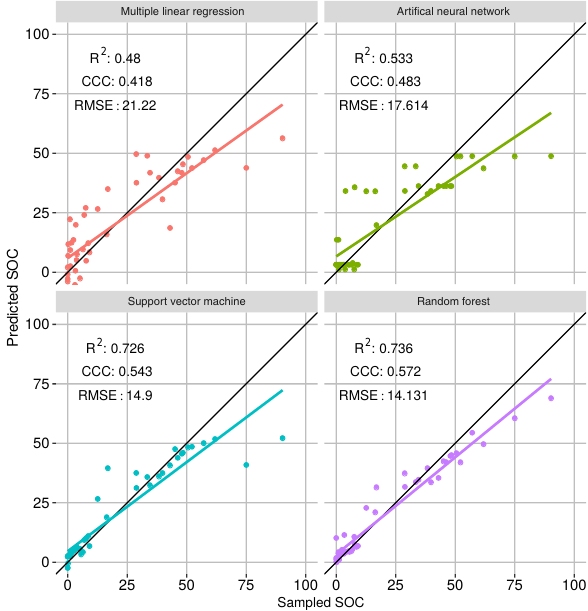
Figure 5. Performance of different prediction models developed us- ing the soil pedon dataset excluding pseudo-training samples. The evaluation is based on observed against predicted total soil organic carbon (SOC) values. The performance metrics are based on cross- validation ( R 2 : coefficient of determination, CCC: Lin’s concor- dance correlation coefficient (CCC) and RMSE: root mean squared